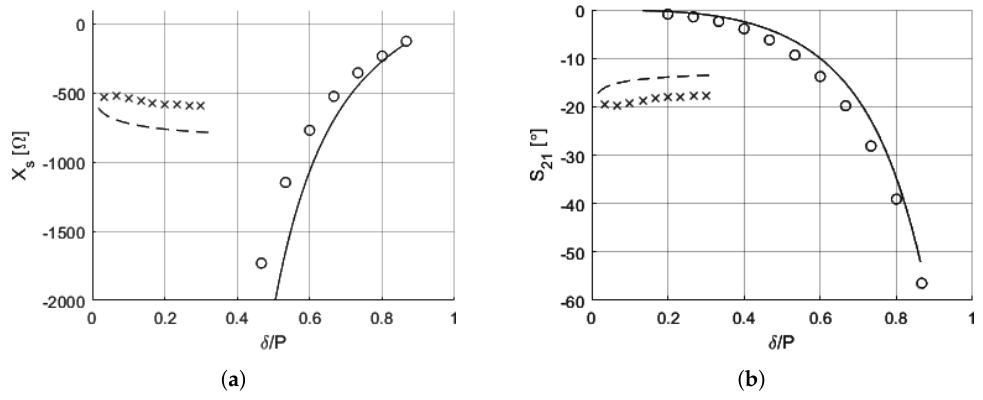
Figure 8. Performance of loop unit cells. Lines are analysis, points simulation results. Solid and circles— δ ∼ d , w = P /15; dashed and crosses— δ ∼ w , d = 2 P /3. ( a ) Surface reactance; ( b ) phase